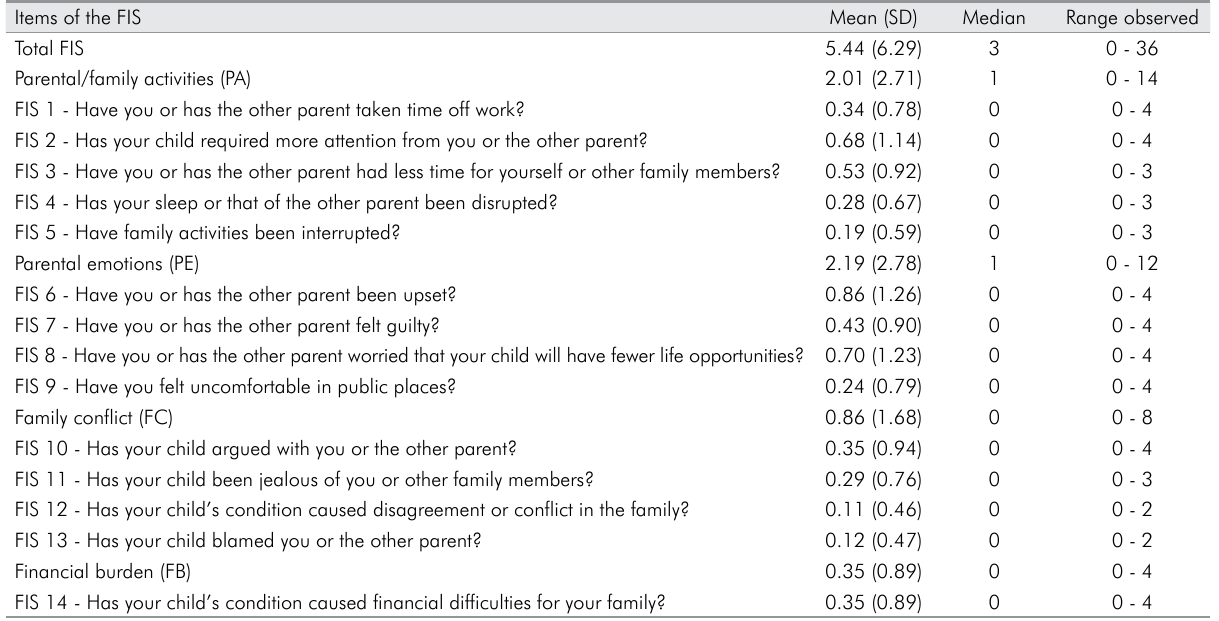
Table 2. Mean, standard deviation, median, and range observed in the FIS (Family Impact Scale). Items of the FIS